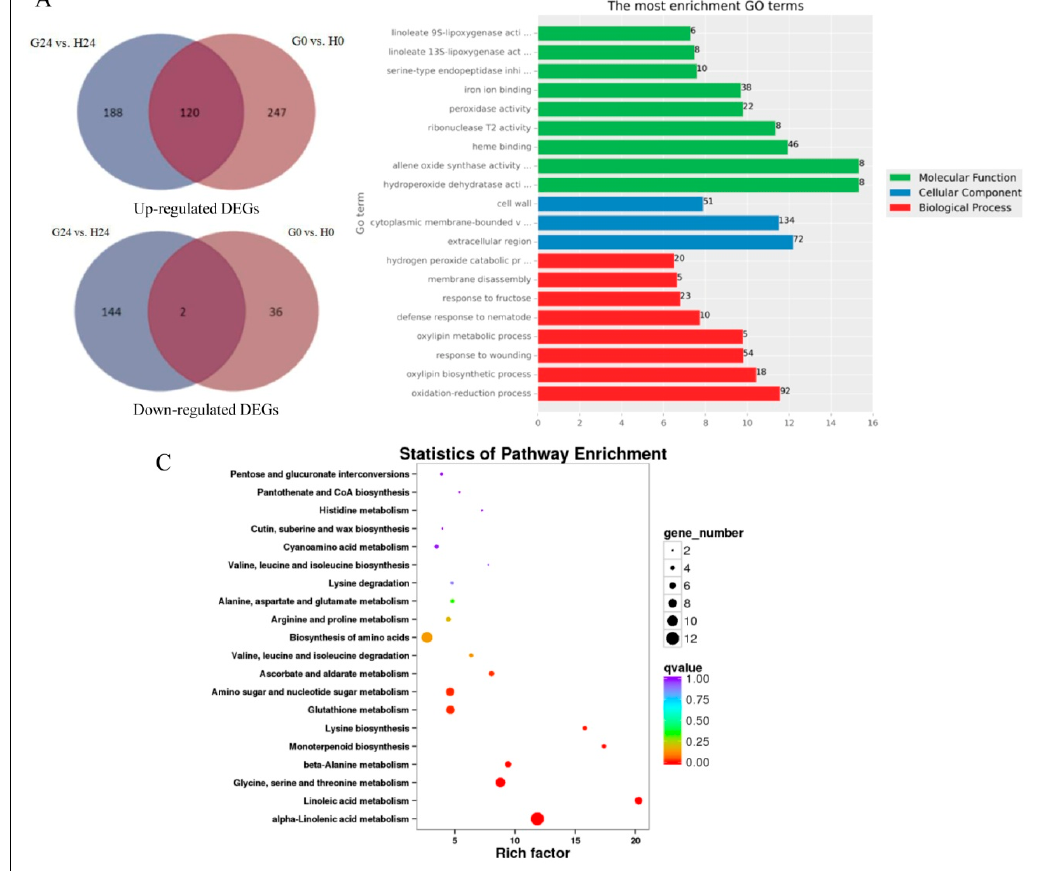
Figure 7. Content of abscisic acid (ABA), auxin (IAA), jasmonic acid (JA), and salicylic acid (SA) levels in water-treated and glycerol-treated Xuezao leaves. Each value is the mean ± SE of three independent biological repetitions. Asterisks indicate a significant difference from the water-treated mock control at p ≤ 0.05 determined by Student’s t -test.